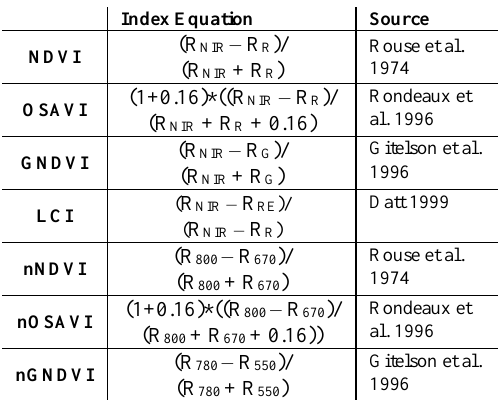
Where R = reflectance (%), R R = red, R G = green, R B =